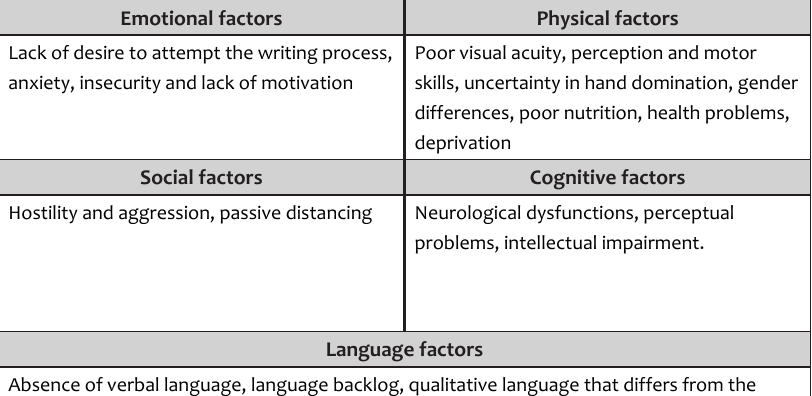
Table 2: Contributing factors and challenges impacting the writing process Emotional factors Physical factors Lack of desire to attempt the writing process, Poor visual acuity, perception and motor anxiety, insecurity and lack of motivation skills, uncertainty in hand domination, gender differences, poor nutrition, health problems, Social factors Cognitive factors Hostility and aggression, passive distancing Neurological dysfunctions,